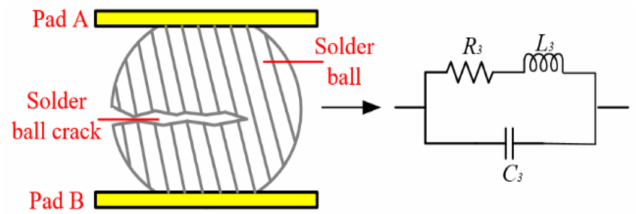
Figure 6. Equivalent connection impedance network of a cracked solder